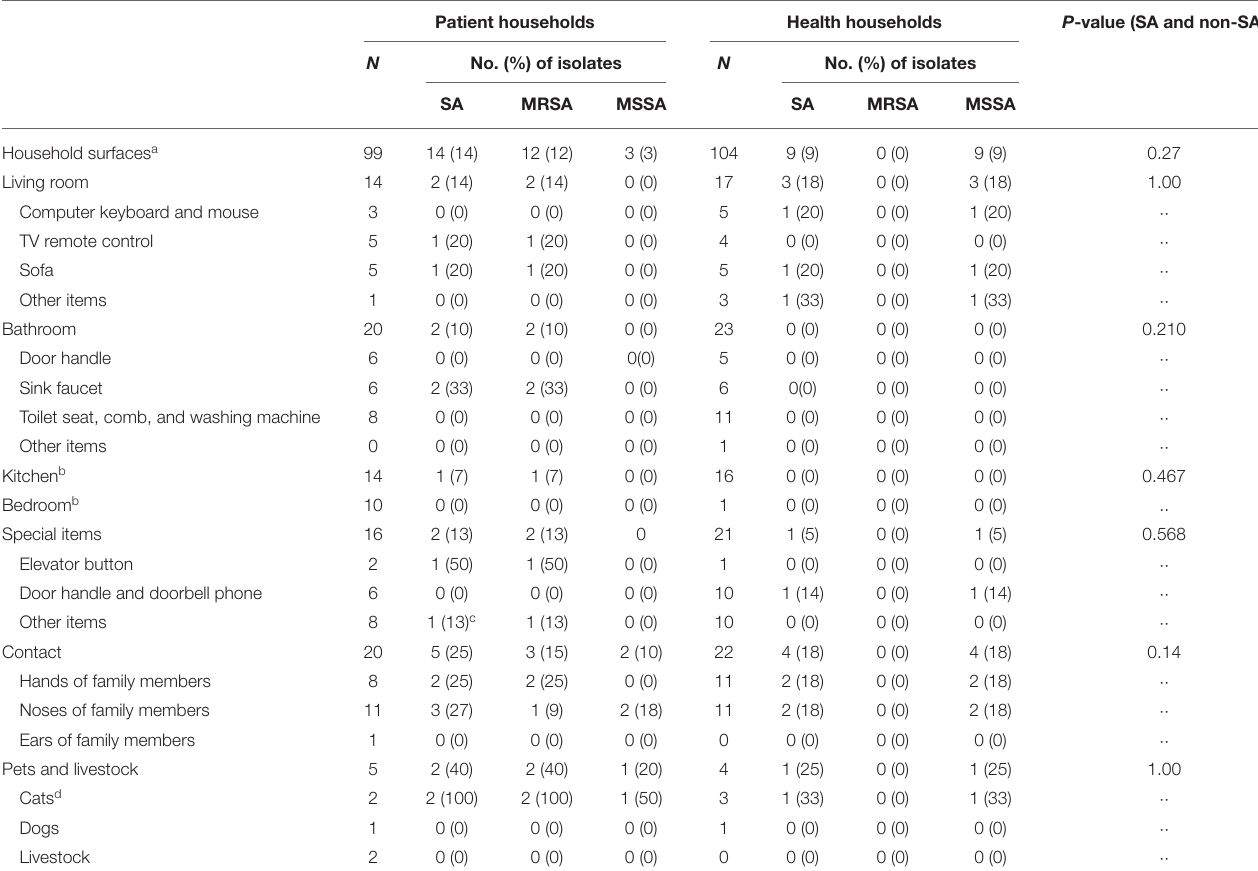
TABLE 1 | Prevalence of Staphylococcus aureus on domestic environmental surfaces, contacts, and pets and poultry. Patient households Health households P -value (SA and non-SA) N No. (%) of isolates N No. (%) of